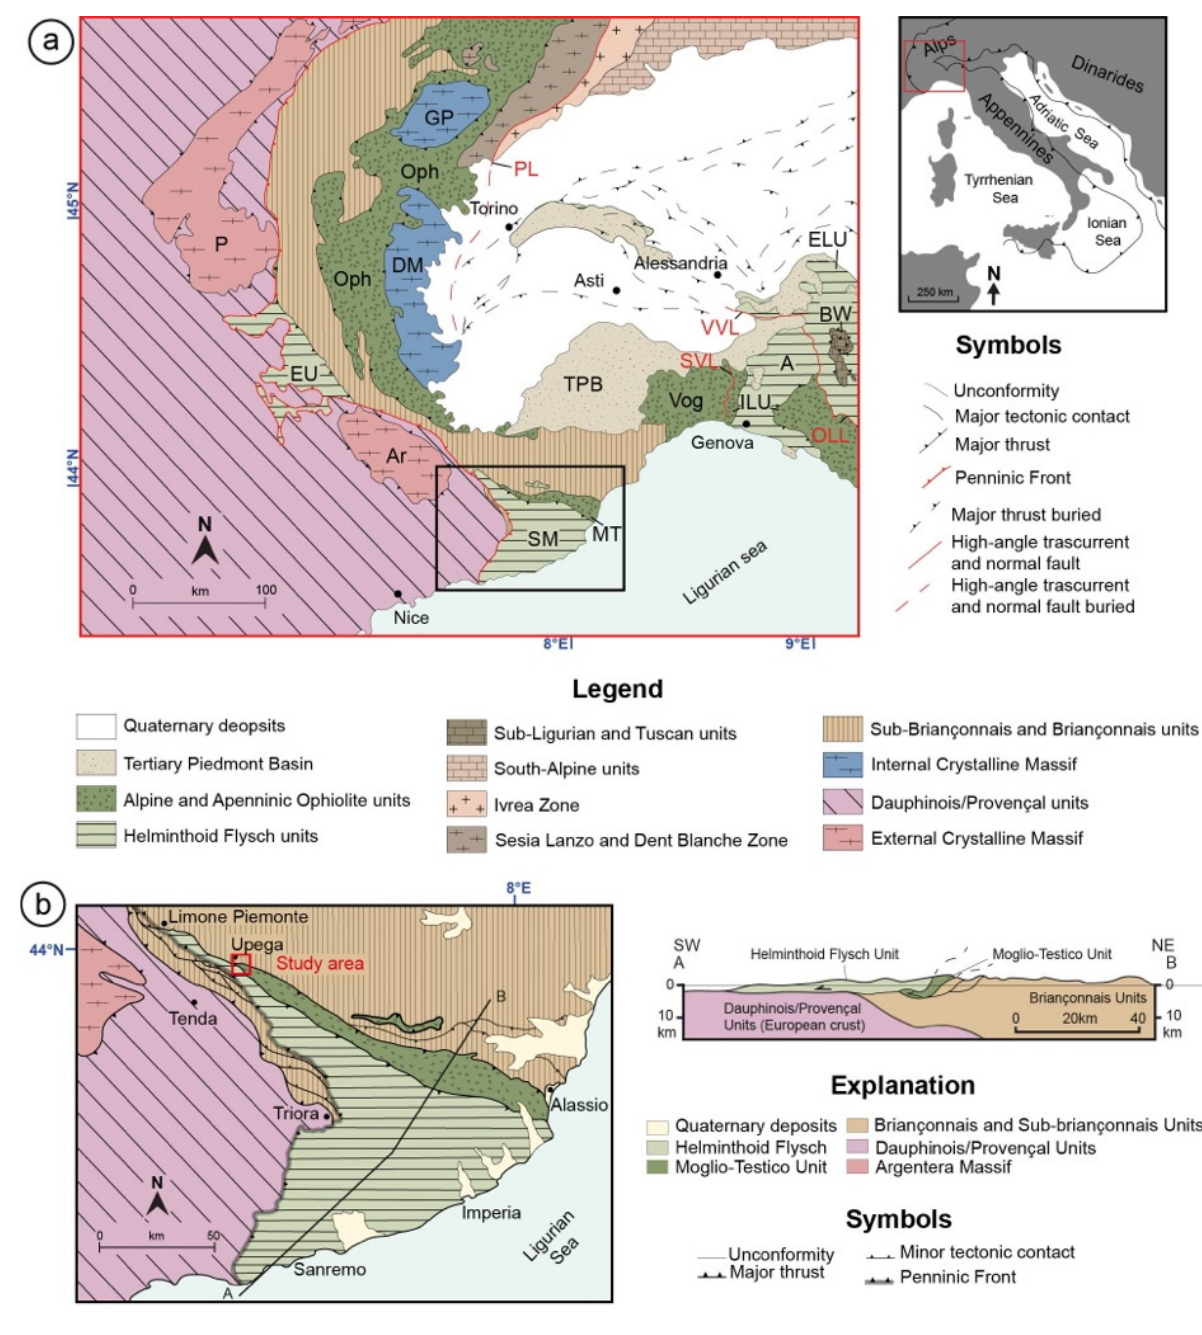
Figure 1. ( a ) Geological setting of the Western Alps re-drawn and modified by [7]; ( b ) the Western Ligurian Alps segment (black box in ( a )). The red box marks the mapped are of Figure 2a. TPB: Tertiary Piedmont Basin; GP: Gran Paradiso; DM: Dora Maira; Oph: ophiolite units; MT: Moglio-Testico Unit; Vog: Voltri group; SM: San Remo-Monte Saccarello Unit; EU: Embrunais-Ubaye; A: Antola Unit; ILU: Internal Ligurian Units; ELU: External Ligurian Units; BW: Bobbio Window; P: Pelvoux; Ar: Argentera; PL: Periadriatic Line; SVL: Sestri-Voltaggio Line; VVL: Villaverna-Varzi Line; OLL: Ottone-Levanto Line.